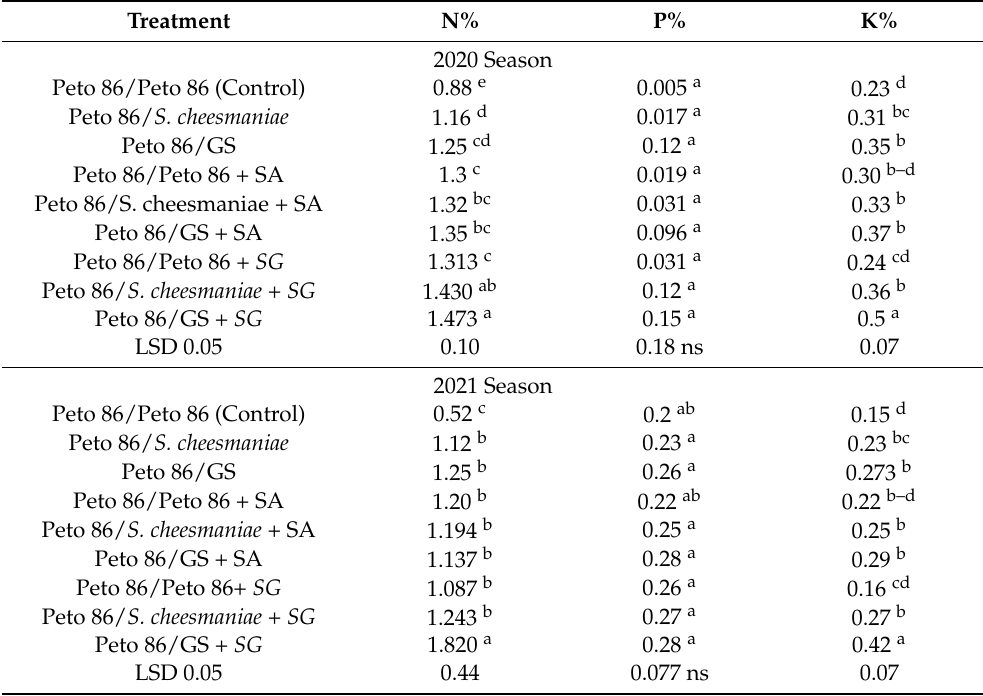
Table 4. Effects of grafting, seed priming with shikimic acid (SA), and colonisation with S. griseus (SG) on macronutrients of tomato fruits during 2020 and 2021